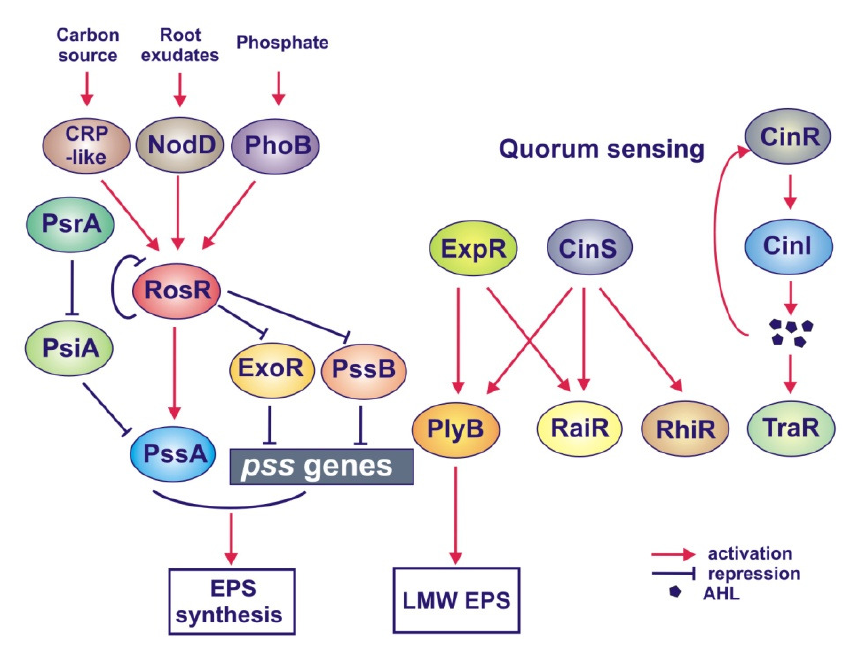
Figure 5. Model of regulation of EPS synthesis in R. leguminosarum